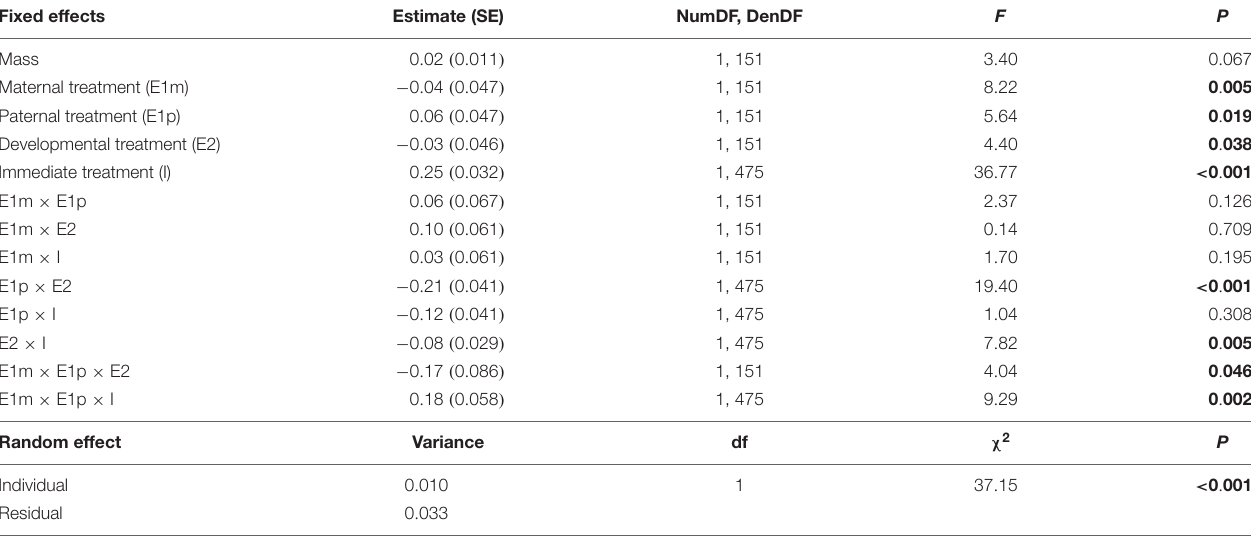
TABLE 1 | Results on the linear mixed model on escape